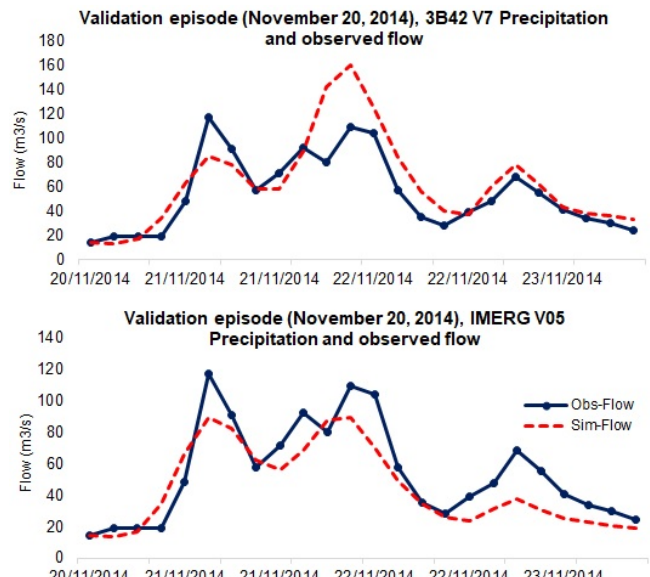
Figure 3. Validation of the episode of 20 November 2014, of 3B42V7 and IMERG V05 rainfall products and observed runoff data as input using the means calibration parameters of the gauge precipitation